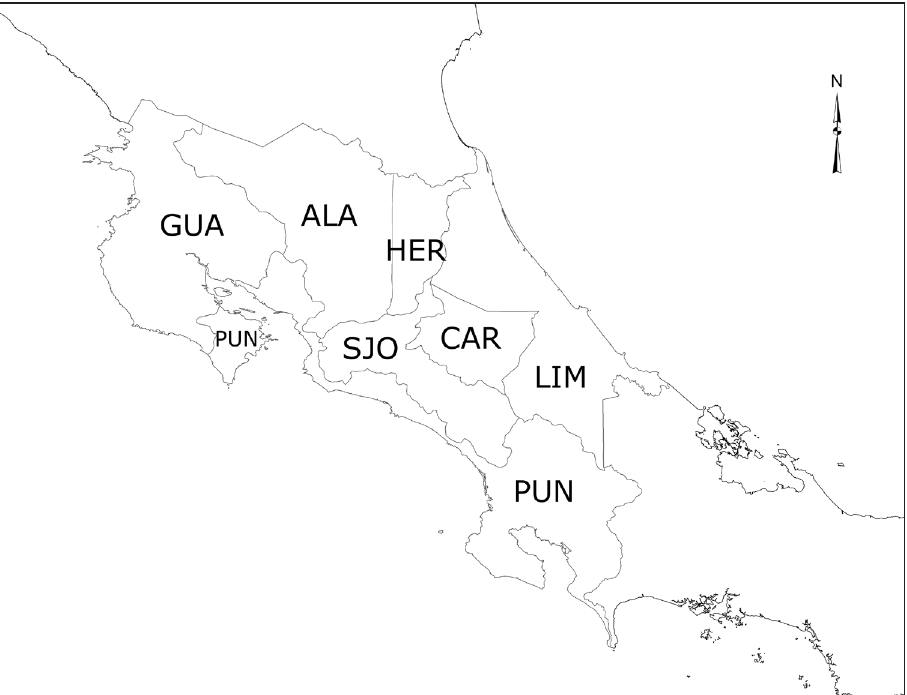
Figure 1. Map of Costa Rica showing provinces. ALA: Alajuela; CAR: Cartago; GUA: Guanacaste; HER: Heredia; LIM: Limón; PUN: Puntarenas; SJO: San